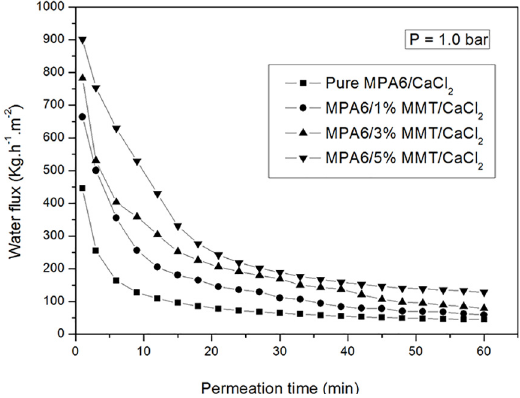
Figure 7. Pore size distribution for pure PA6 membranes and their hybrids with 1, 3, 5% of MMT, adding the additive CaCl mercury intrusion porosimetry.